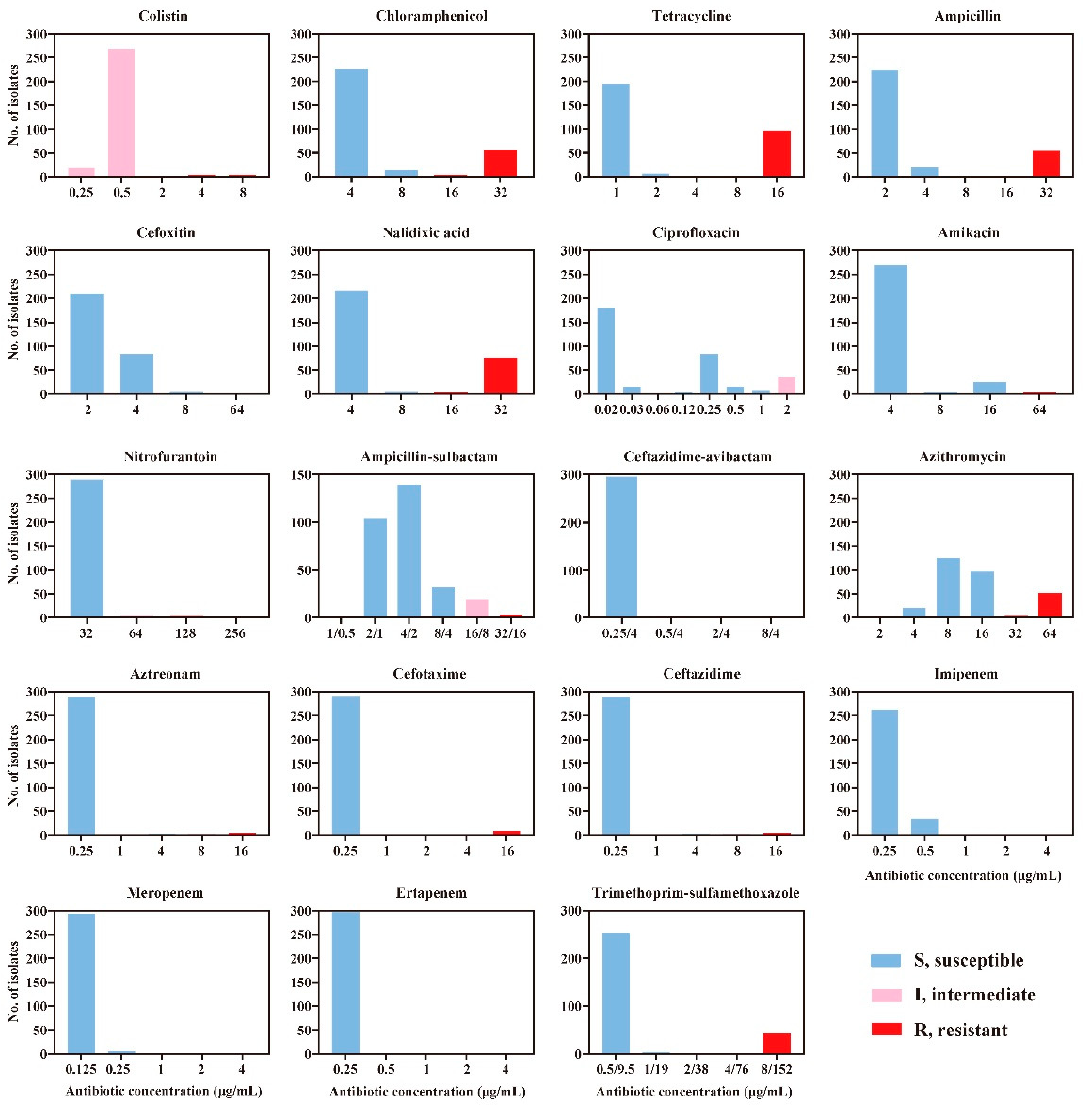
Figure 1. Distribution of minimum inhibitory concentration (MIC) values of 19 antimicrobials among the 298 non-O157 STEC isolates tested in this